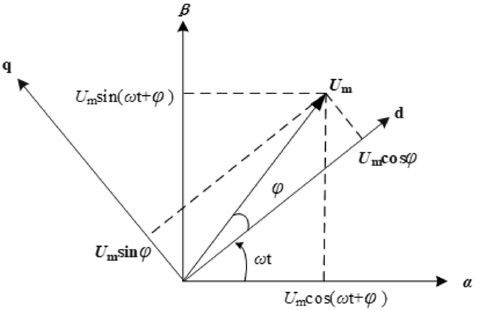
Figure 2. The schematic diagram of αβ / dq coordinate